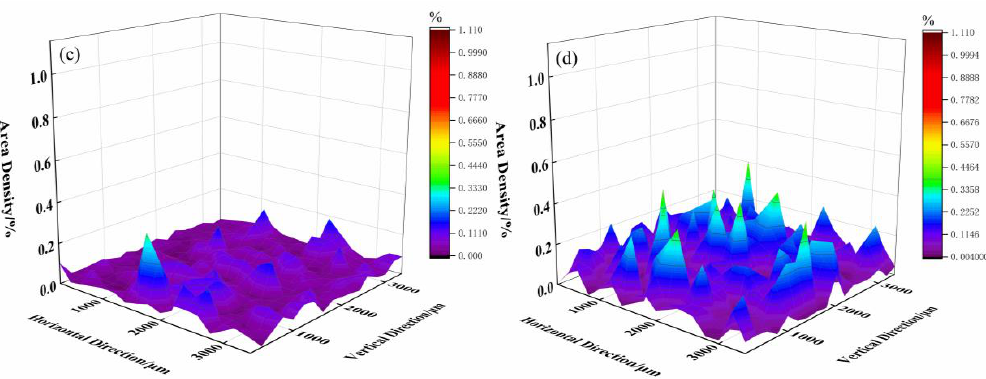
Figure 4. Density distribution of the inclusions on the cross-section. ( a ) Sample S1 area density distribution, ( b ) Sample S2 area density distribution, ( c ) Sample S3 area density distribution, ( d ) Sample S4 area density distribution.